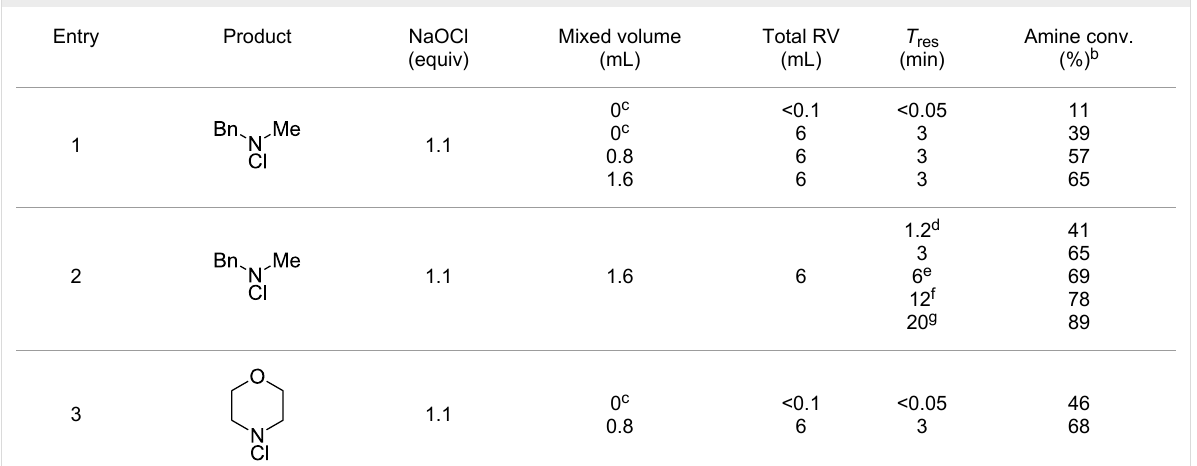
Table 1: Effect of reactor parameters on chloramine formation. a